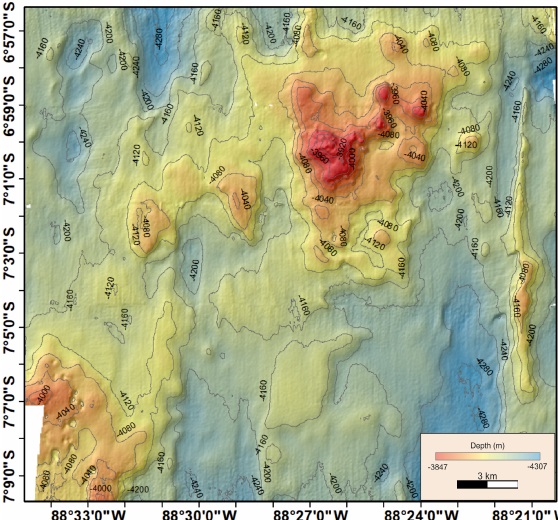
Figure A3. Relief changes in the DisCOL Experimental